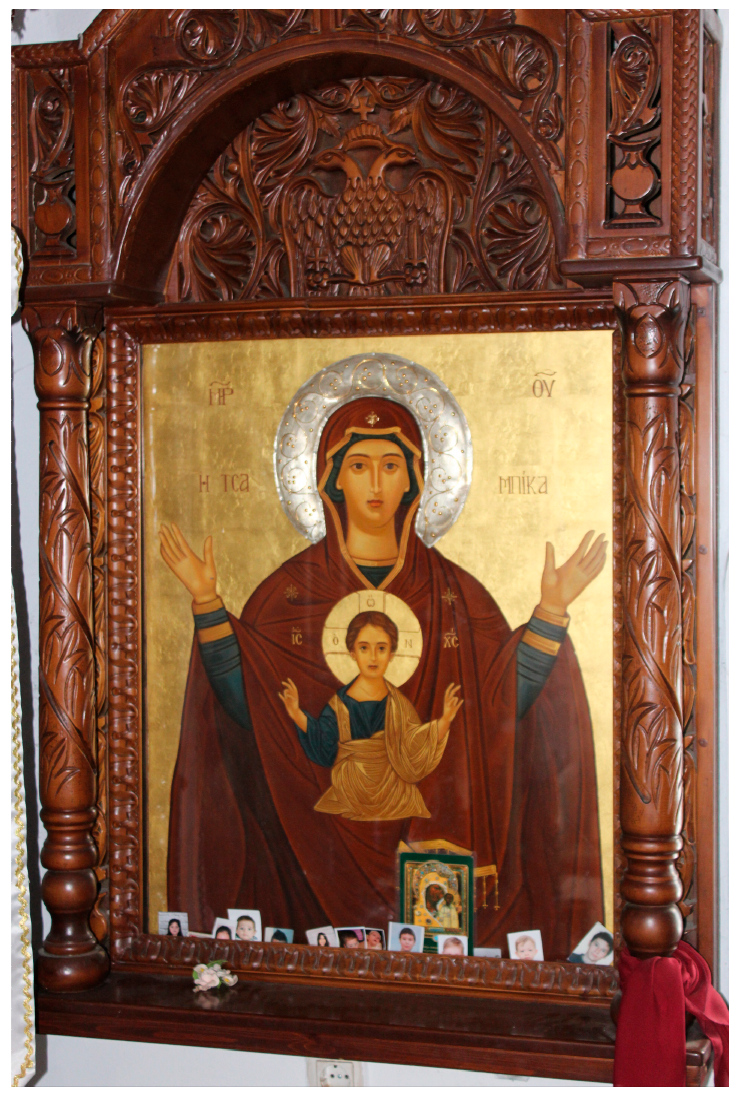
Figure 1. Panaghia Tsambika (copy), Rhodes, Greece (photo by authors).